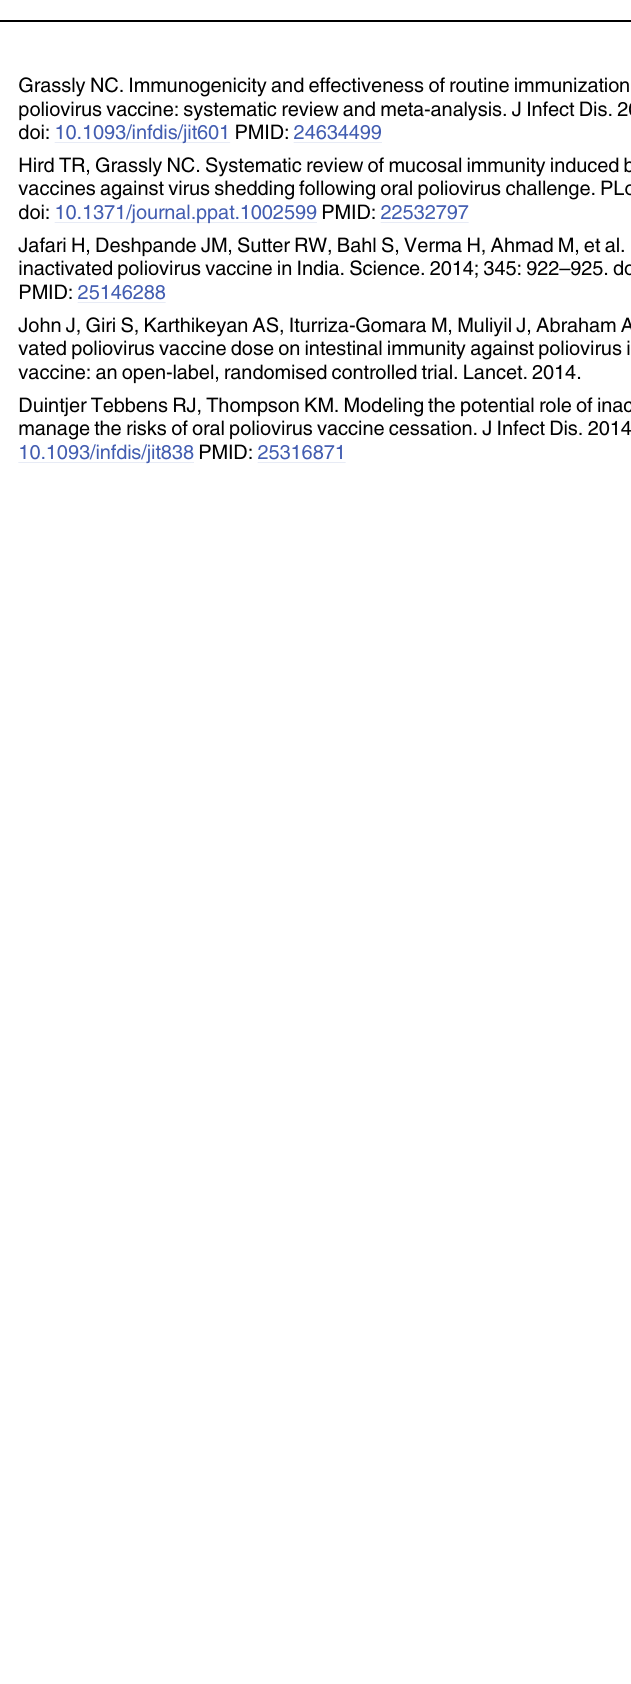
PLOS Pathogens | DOI:10.1371/journal.ppat.1005728 July 6,